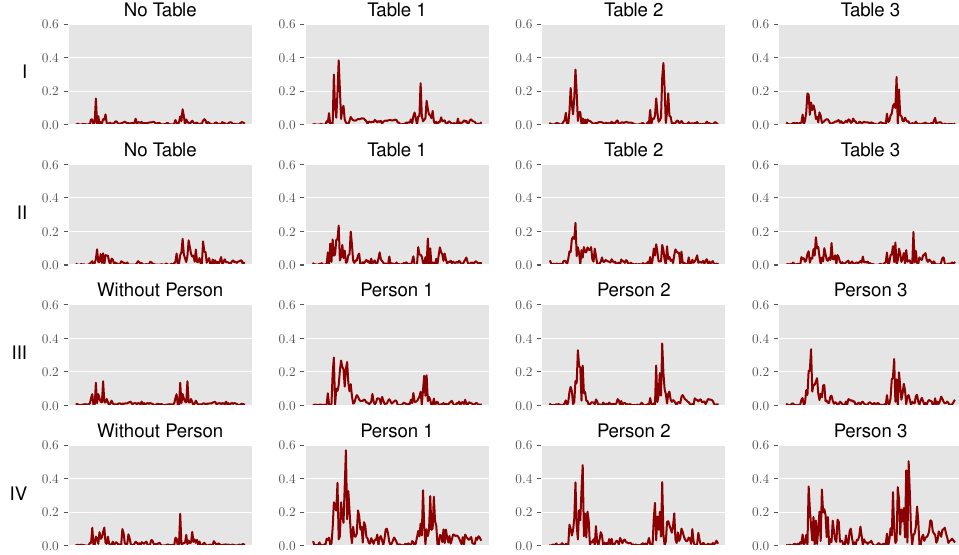
Figure 13. Example of CIR time series for each dataset (I–IV) across the different detection scenes. As the reference CIR is obtained from an averaged set of CIRs, differences after